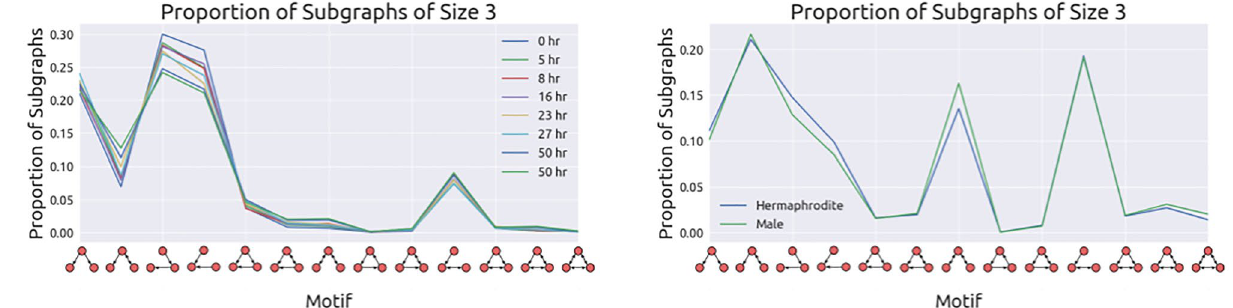
Figure 3. Subgraph distributions of size three. The distributions of subgraphs of size three are similar in the C. elegans developmental (left) and the C. elegans sexes (right) datasets (cosine similarities > 0.977 and 0.995, respectively). Note that these datasets are not comparable to one another since the datasets differentiating the two sexes include muscles, non-muscle end organs, and glial cells.